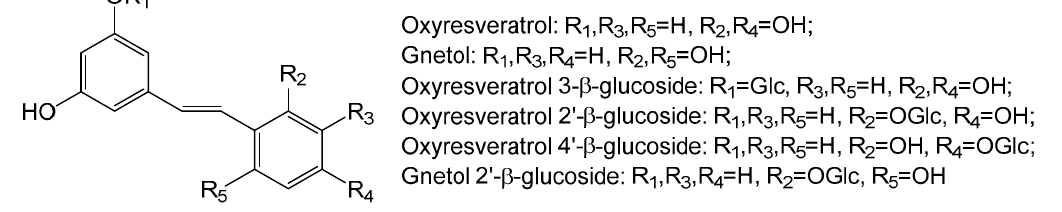
Figure 1. Chemical structures of stilbene compounds.